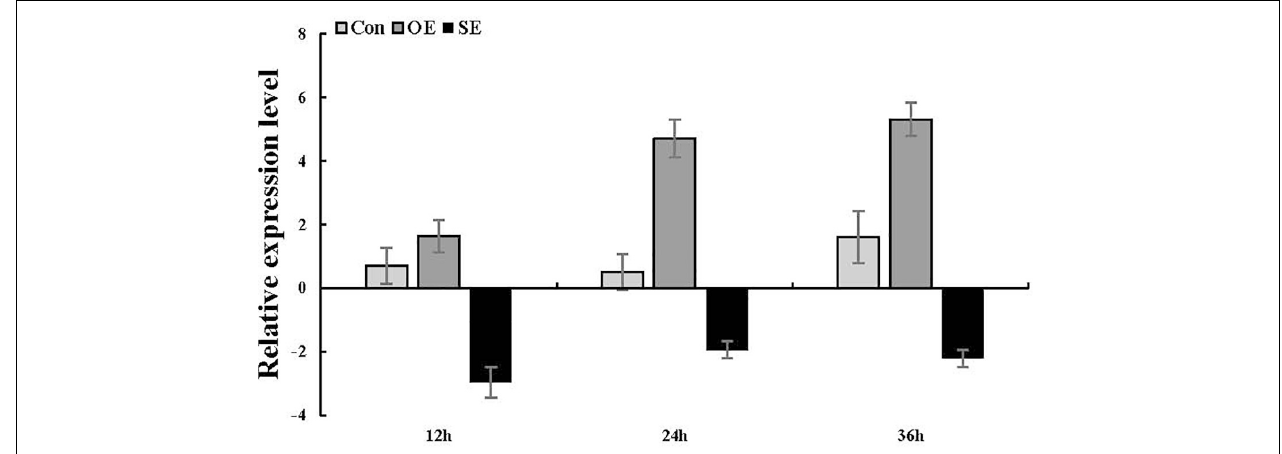
FIGURE 3 | ThSOS3 transcript levels in T. hispida plants with transient overexpression or knockdown of ThSOS3 . The expression data were log2-transformed. Two-month-old T. hispida plants were transiently transformed with empty pROKII, 35S:: SOS3 or pFGC:: SOS3 . After transformation for 36 h, T. hispida plants were treated with 150 mM NaCl for 12, 24, or 36 h, and the expression of ThSOS3 was determined. OE, ThSOS3 overexpression; SE, ThSOS3 RNAi; Con, pROKII vector